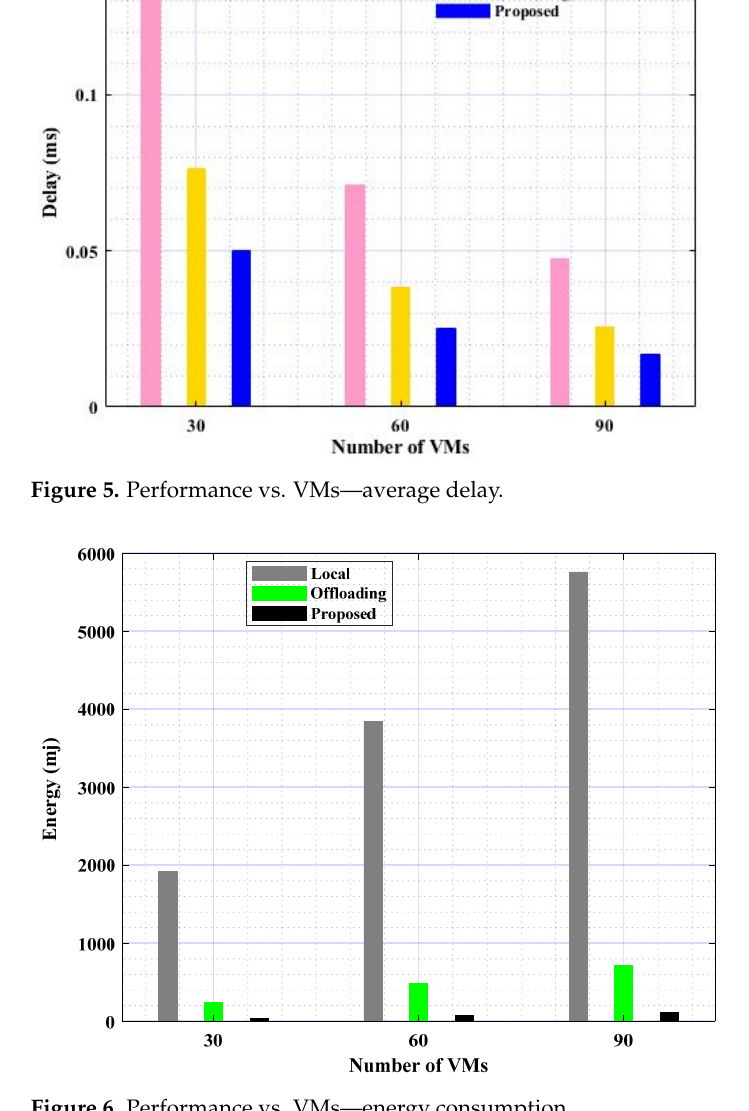
Figure 6. Performance vs. VMs—energy consumption.